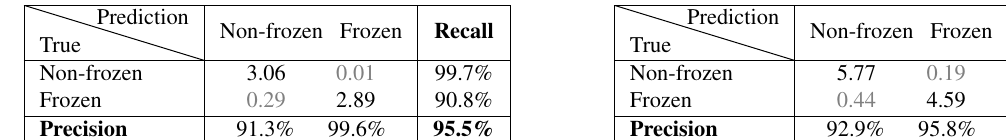
Table 4: Results for winter 2016 - 17 (left) and 2017 - 18 (right). Data from all the three lakes from winter 2016 - 17 was used to train the model that was tested on winter 2017 - 18 , and vice versa. Confusion matrices are shown. Units are in millions of pixels, except for precision, recall, and accuracy (bottom right cell in each table).